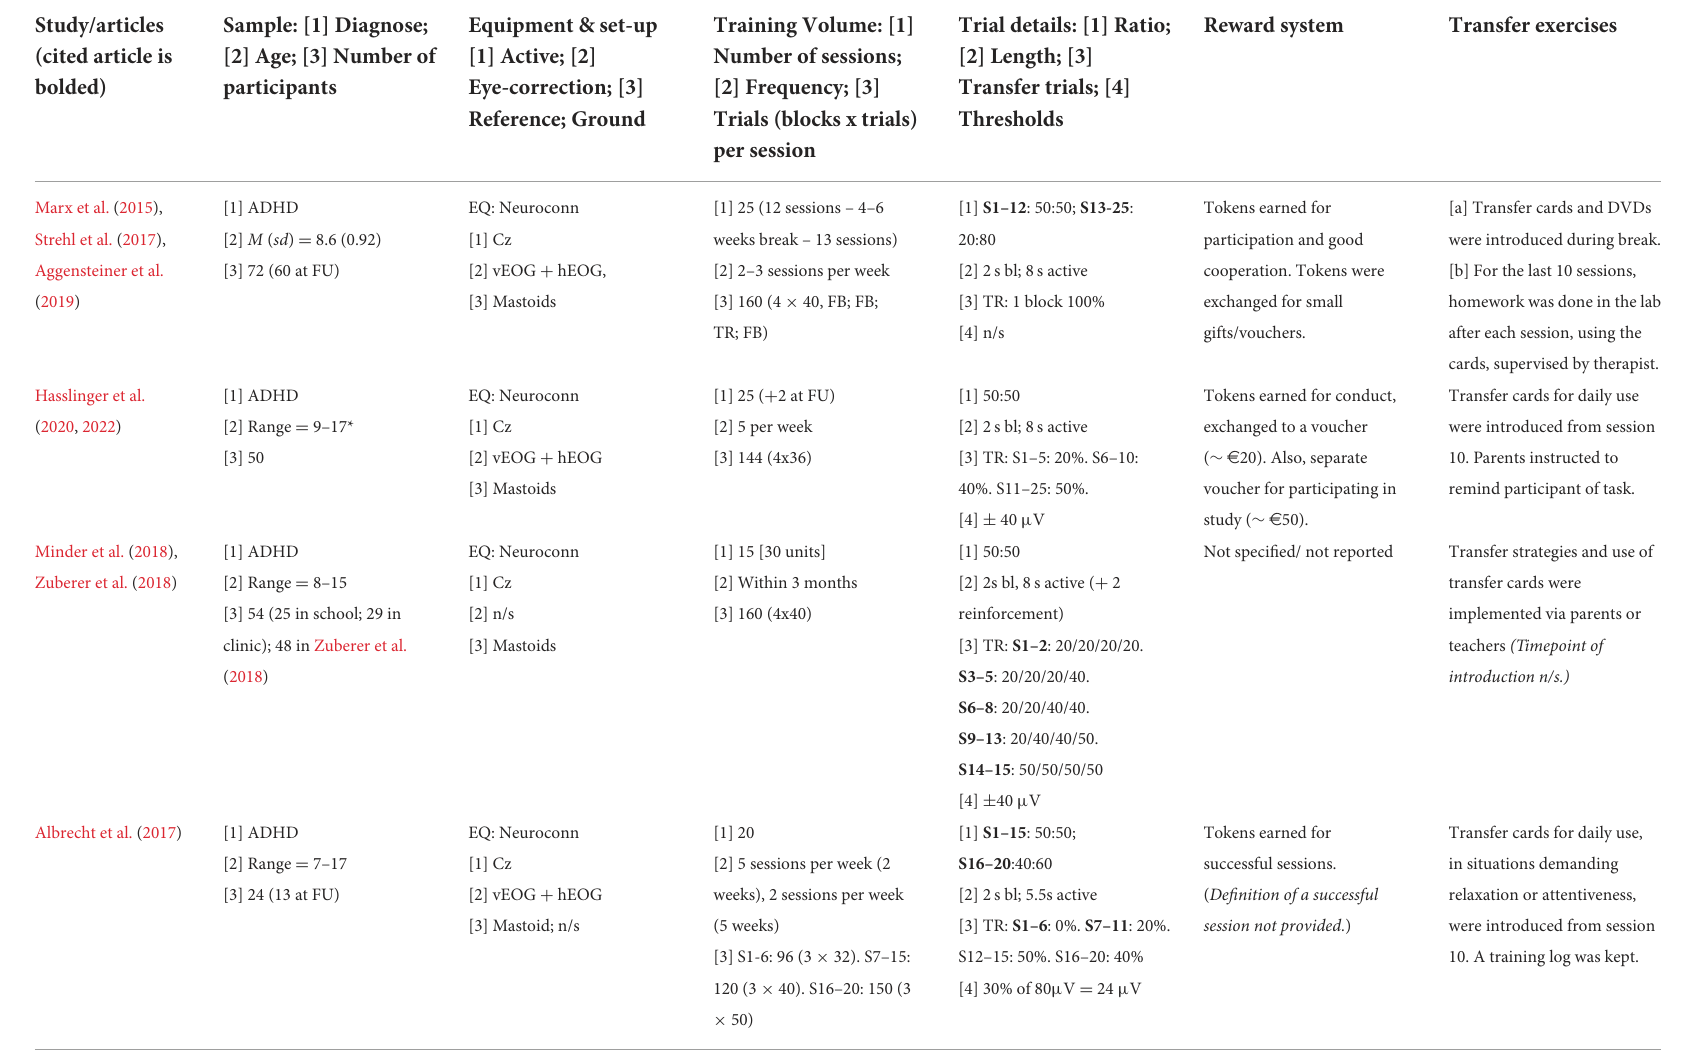
TABLE 1 Summary of protocol-details of included